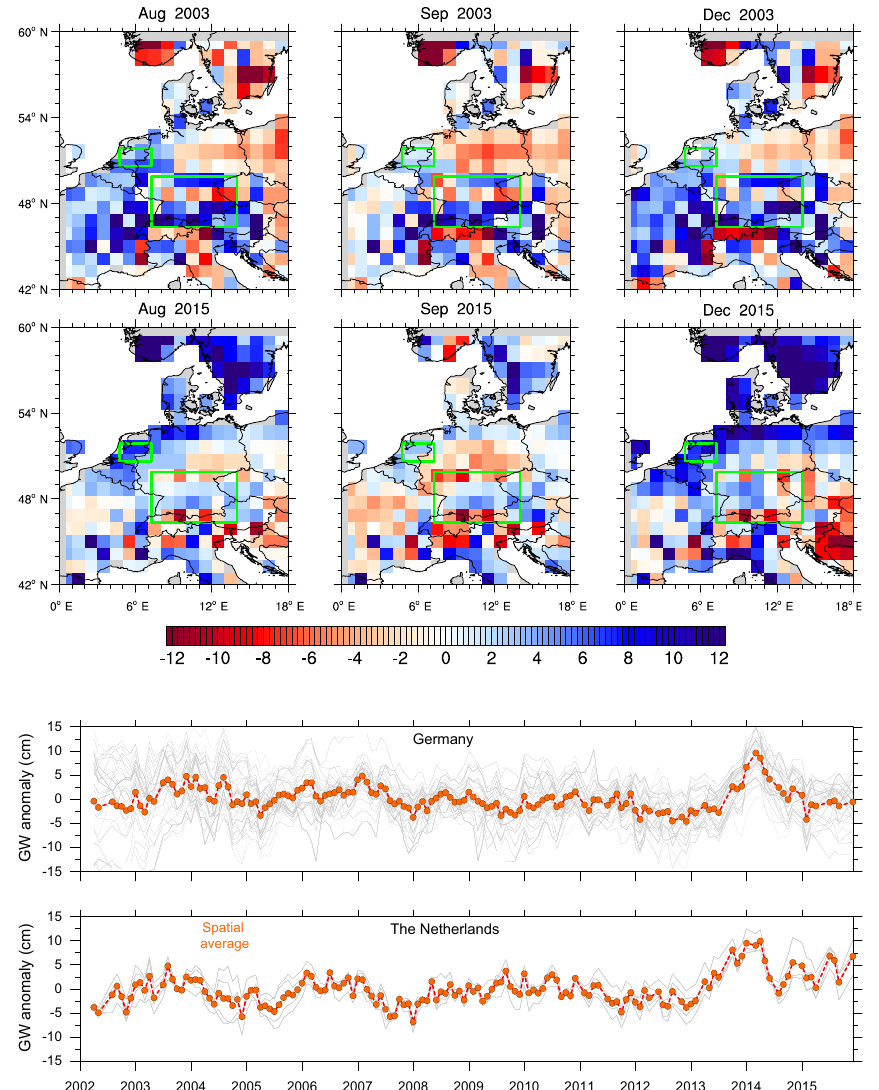
Figure 8. Groundwater anomalies (cm) based on GRACE and GLDAS model outputs for the available 3 common months (August, Septem- ber, and December) during the 2003 and 2015 drought events (top panels), estimated by removing the total surface water storage anomaly (TOW, which is the combination of soil moisture, canopy storage, and snow water equivalent) from the GRACE-TWS anomaly (Fig. 3). The TOW estimates are based on mean simulations from four GLDAS models (CLM, NOAH, VIC, and MOSAIC). The plots are based on the ensemble mean of these four model outputs. The bottom two panels depict the monthly GRACE-GLDAS groundwater anomalies for every grid cell located within the study domains (shown in the green boxes in the top panels: south Germany and central Netherlands) as well as their spatial